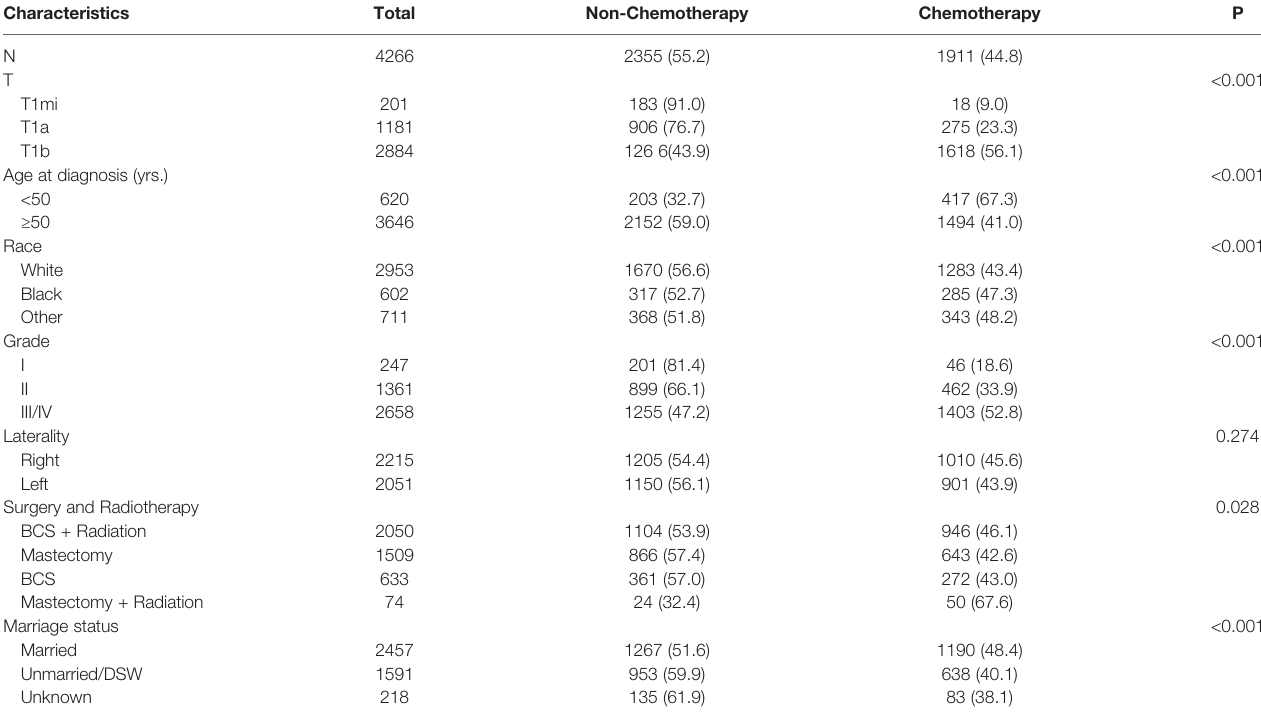
TABLE 1 | Clinical characteristics of node-negative triple-negative breast cancer patients with tumor size less than 1 cm from the SEER database.